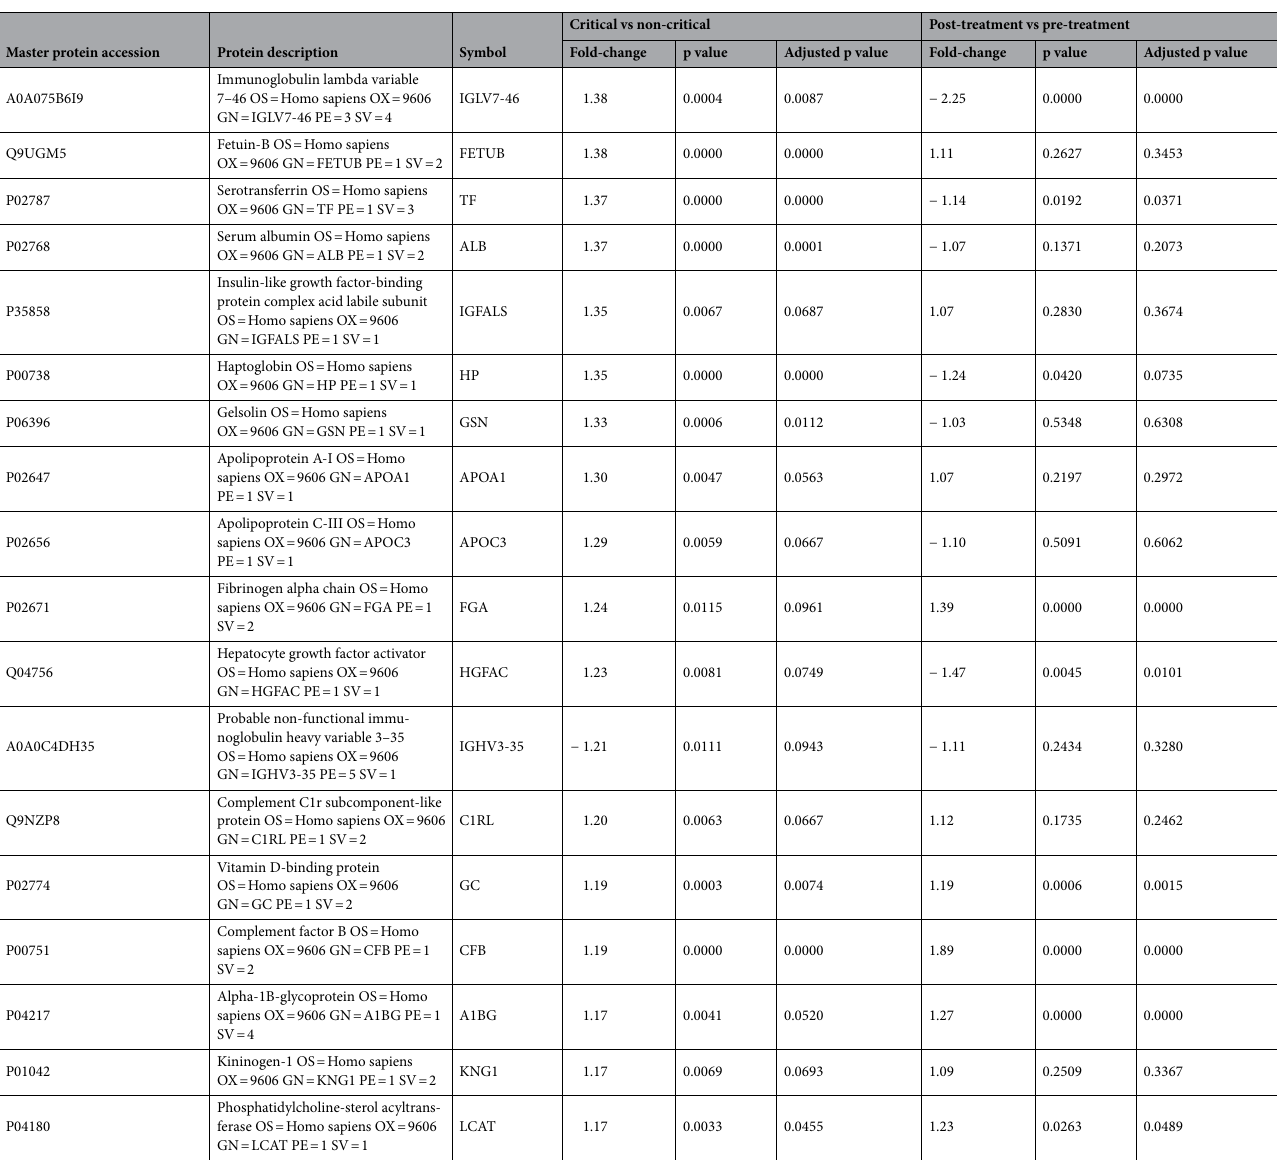
Table 2. Proteins differentially expressed between critical and non-critical patients at 10% of false discovery rate (FDR). The table also shows the results from the analysis comparing Treated and Not-treated samples for the same proteins. Results are derived from a linear mixed-effects model fitted to each protein independently that included peptide and patient as random effects. Digestion batch, evolution group (critical/non-critical), blood extraction day and the interaction of the two latter were modelled as fixed effects. Comparisons were performed by averaging time point estimations within each evolution group. Differences between treatment status were assessed in an analogous way, using a model that included treatment and batch of samples’ digestion as fixed effects. Positive fold-changes indicate over-expression in critical patients or in Treated samples while negative fold-changes represent over-expression in non-critical patients or in Not-treated samples, respectively. Statistical significance was assessed using a Wald test derived from the models. The Benjamini–Hochberg method was used for control of the FDR (Adjusted p